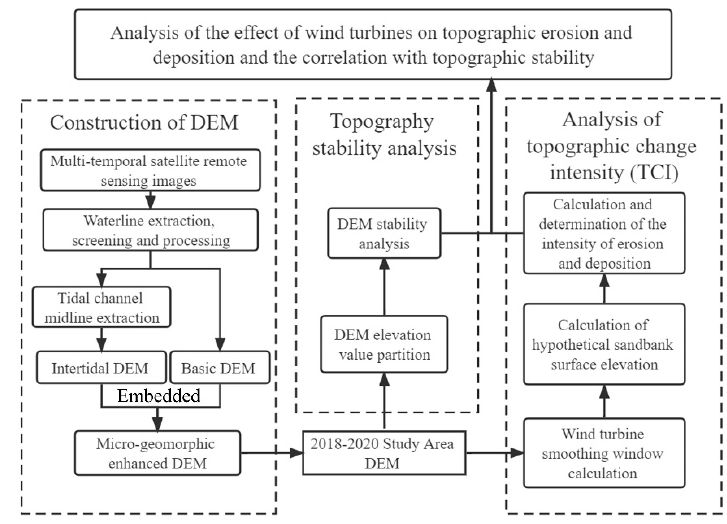
Figure 2. Flow chart of the research technology.